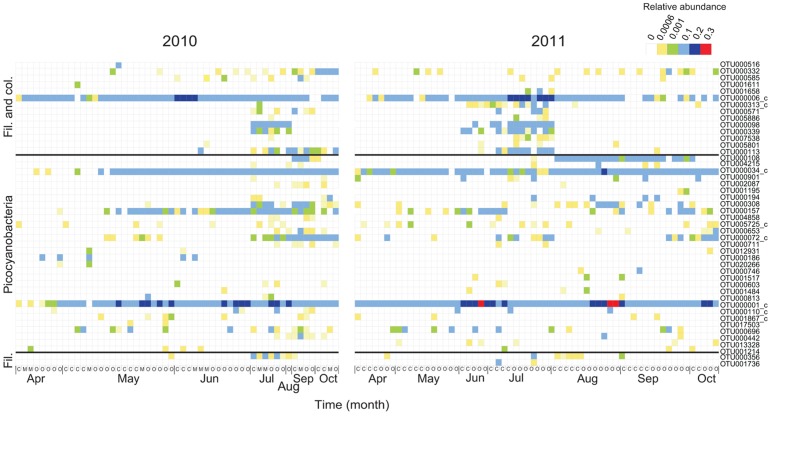
Temporal and spatial dynamics of the 50 most abundant cyanobacterial OTUs (98% identity) for 2010 and 2011, respectively (72 OTUs in total). The order of the OTUs corresponds to Figure 2 and OTUs with <0.01 phylogenetic distance (350 bp long sequences) have been clustered (denoted with c). The colors in the heatmap represent the relative abundance of each OTU in a specific sample. The month of sampling and the classification of each station, coastal (C), intermediate (M), and open (O) are indicated on the X-axis.